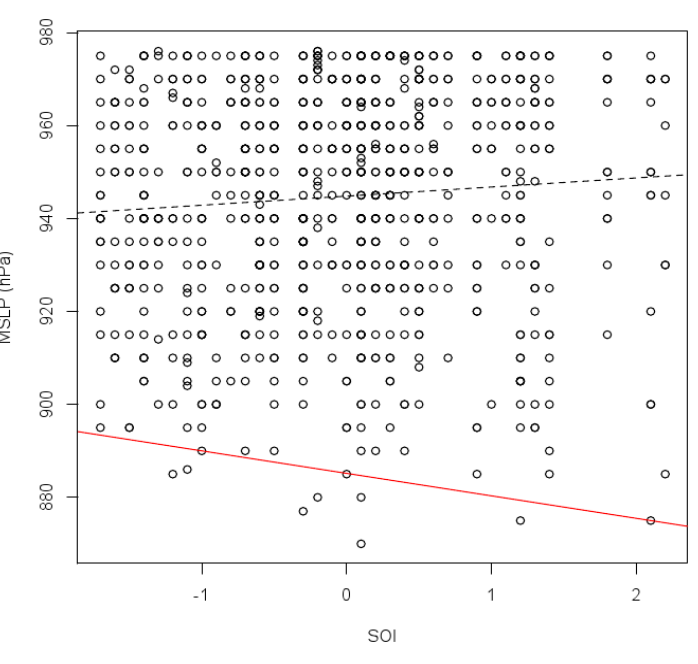
Figure 3. Scatterplot showing the minimum WMO MSLP of western Pacific typhoons 1951–2010, as in Figure 2 but plotted versus Southern Oscillation Index (SOI). Black dashed line is the usual least-squares regression line. The solid red line toward the bottom of the image is the 1% quantile regression